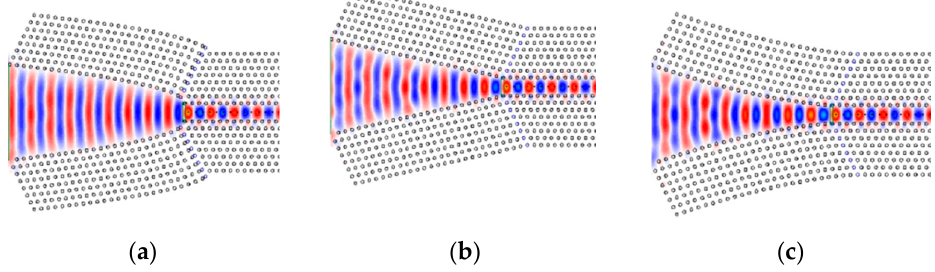
Figure 6. Calculated electric field distribution for a: ( a ) convex taper; ( b ) linear taper; ( c ) concave